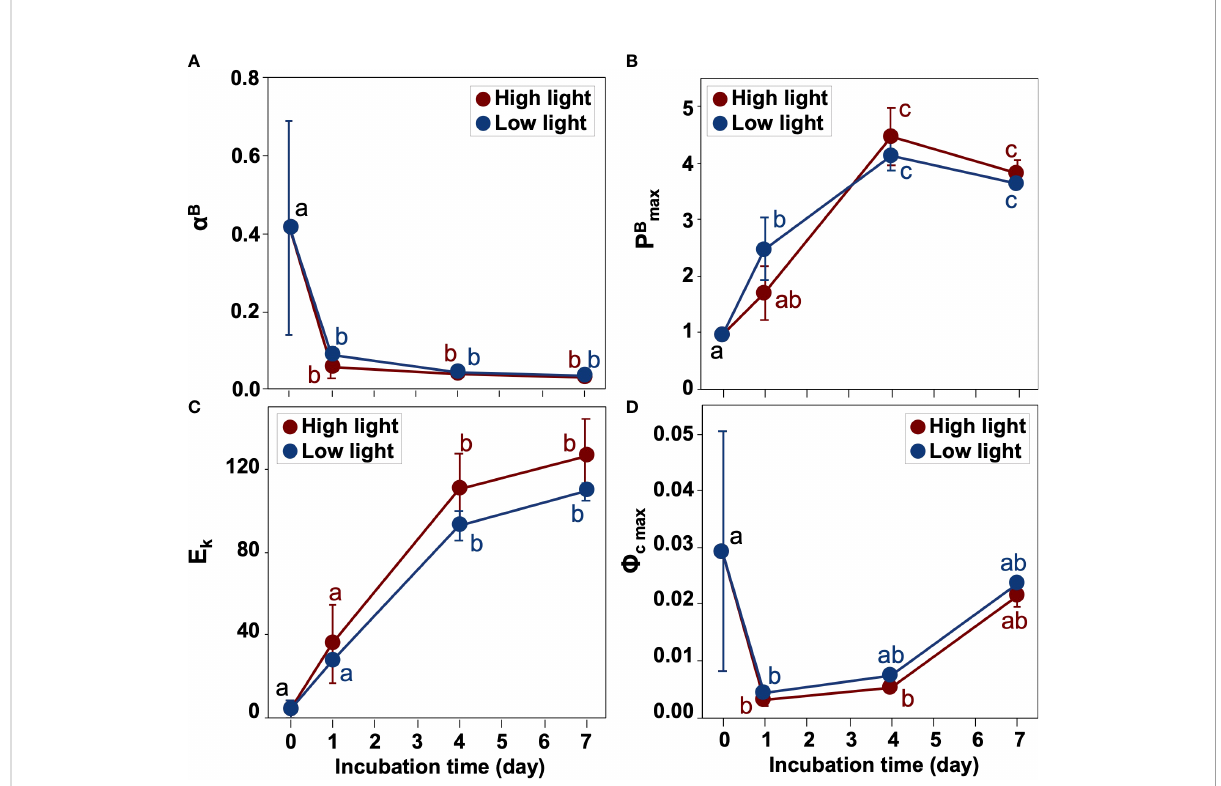
FIGURE 8 Variations in photosynthetic parameters during incubation. (A) the initial slope of the P-E curve normalized by chl a concentrations, a B ((mg C [chl a ] -1 h -1 ) ( m mol photons m -2 s -1 ) -1 ), (B) the maximum photosynthetic rate normalized by chl a concentration, P B max (mg C [chl a ] -1 h -1 ), (C) the photoacclimation index, E k ( m mol photons m -2 s -1 ), and (D) the maximum quantum yield of carbon fi xation, F c max (mol C (mol photon) -1 ). The red and blue colors represent the high (300 µmol photons m -2 s -1 ) and low (30 µmol photons m -2 s -1 ) light conditions, respectively. The alphabets indicate signi fi cant differences among groups (one-way ANOVA and Tukey-Kramer test, p< 0.05). Mean values ( ± SD) represent the average of three independent